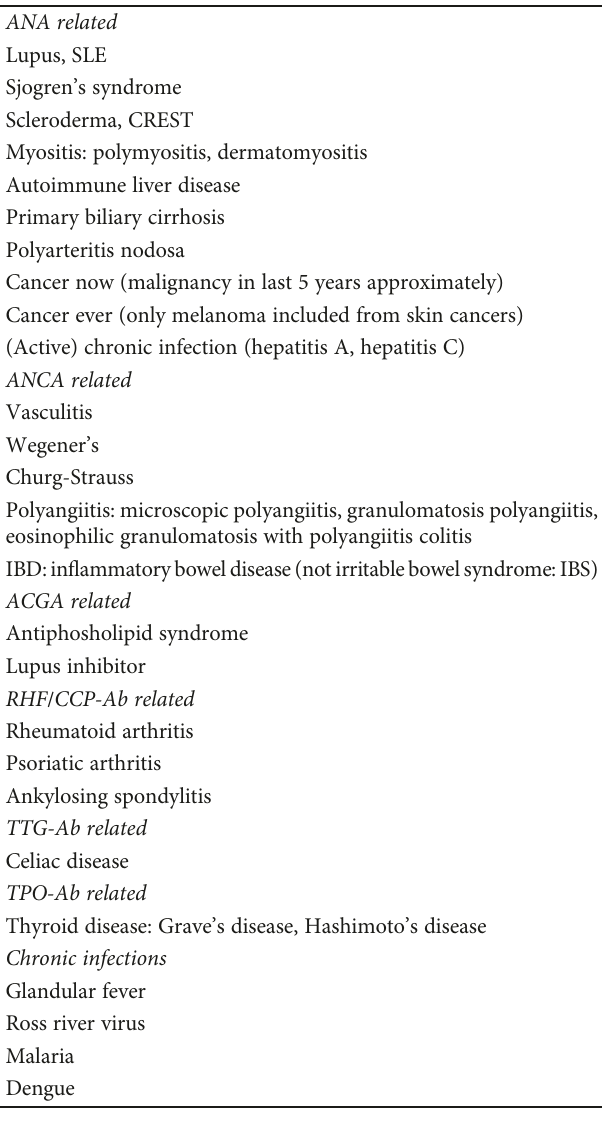
Table 1: Autoimmune conditions and chronic diseases for exclusion.